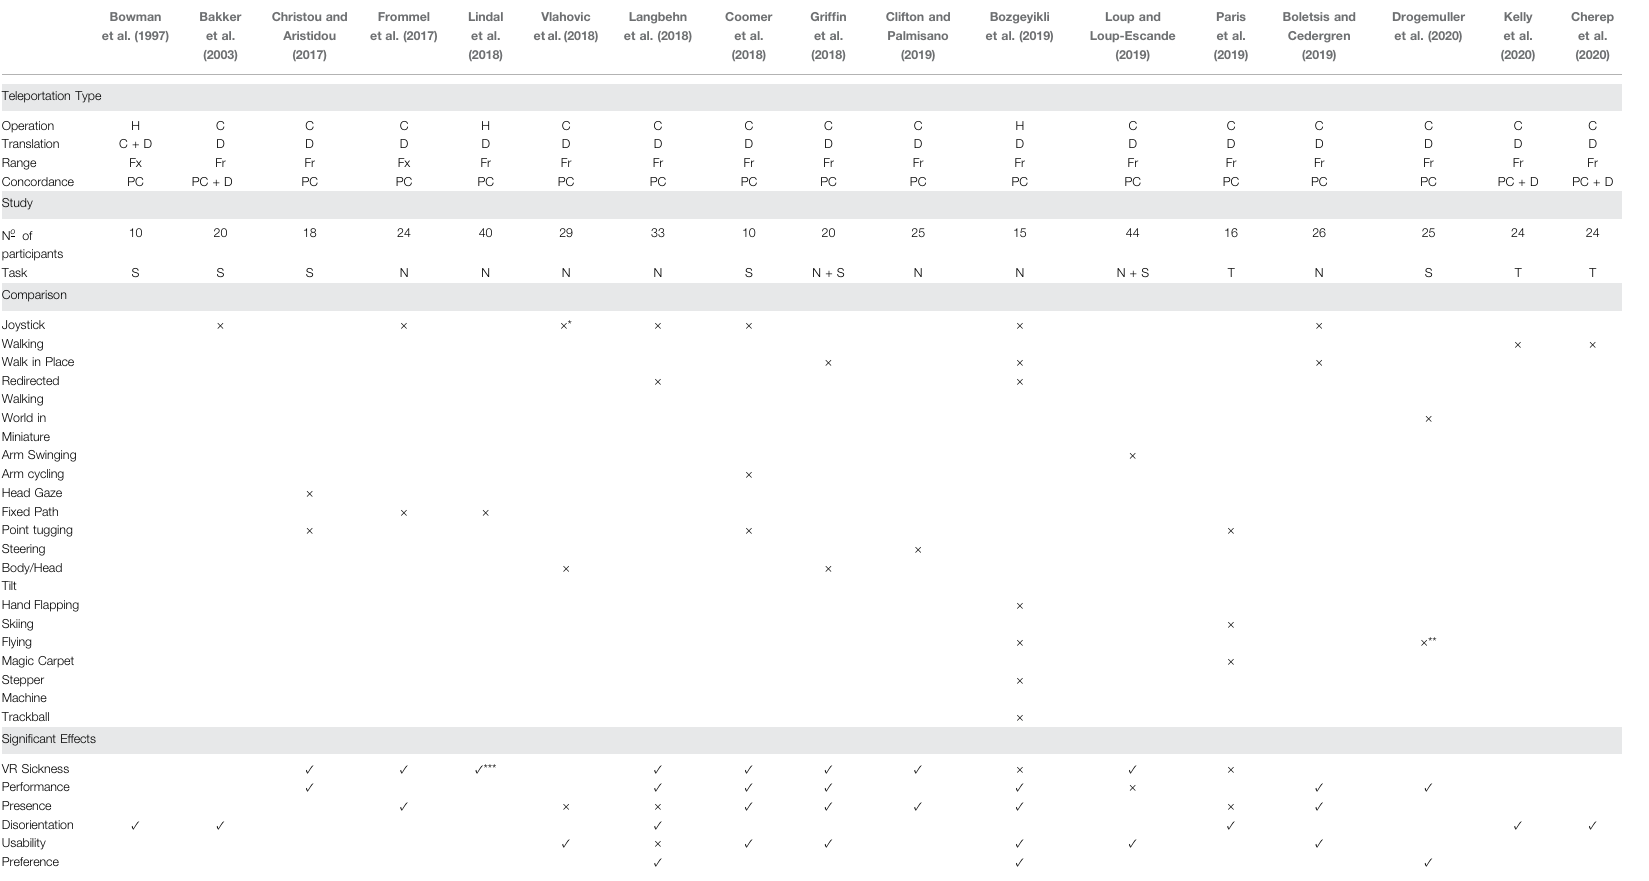
TABLE 1 | The table summarizes how teleportation affects certain factors based on the surveyed studies.